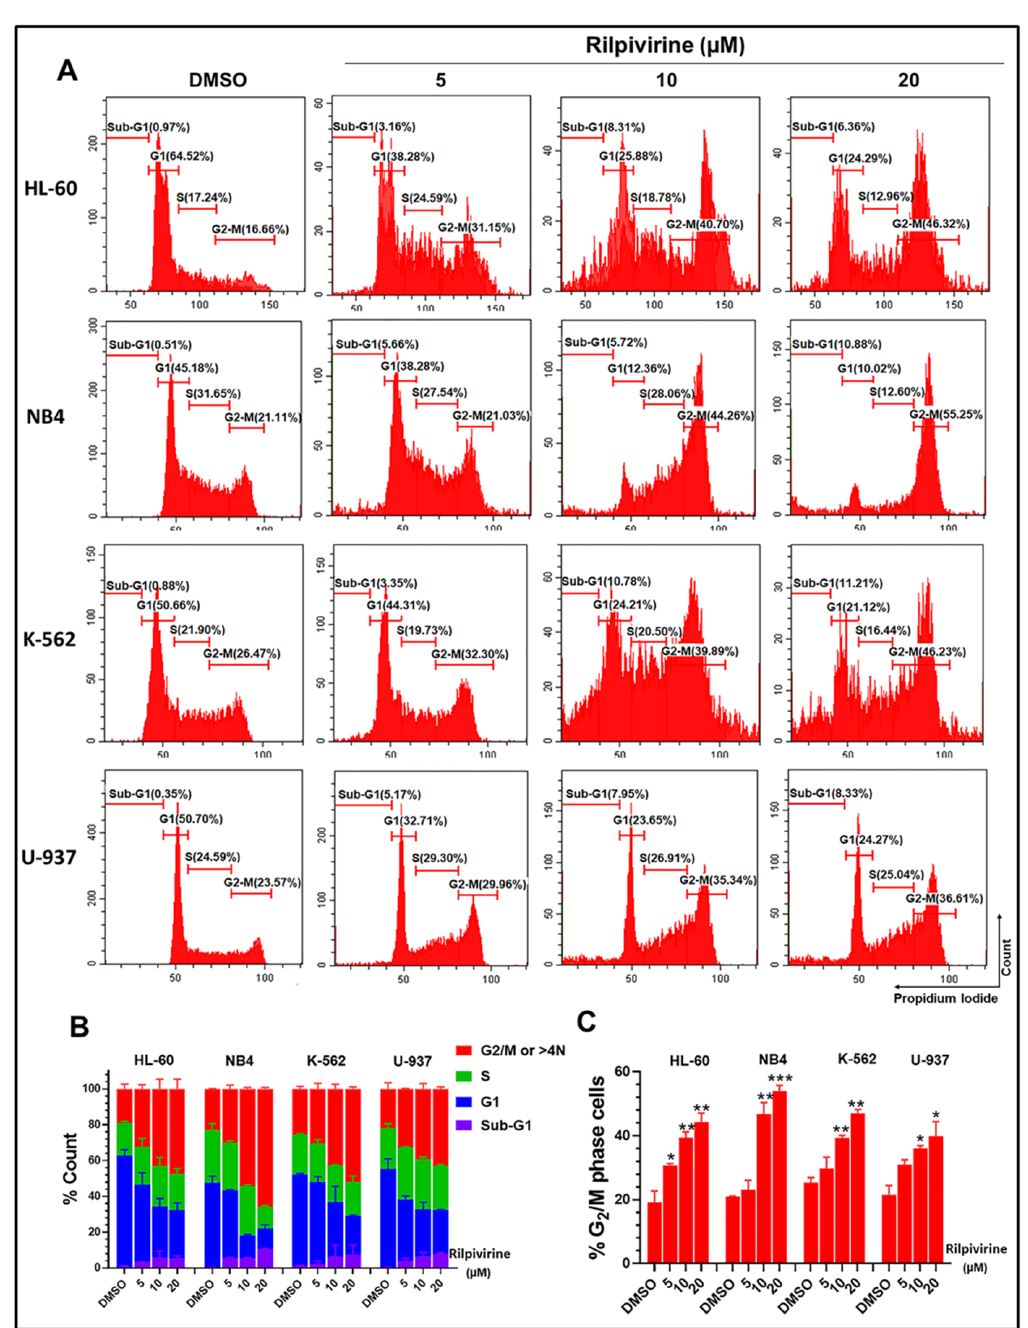
Figure 3. Cell-cycle analysis of leukaemic cells following treatment with rilpivirine. HL-60, NB4, K-562, and U-937 cells were incubated with 5, 10, or 20 µM rilpivirine for 24 h. ( A ) Representative histograms show the distribution of cells in different cell-cycle phases. ( B ) The percentages of cells distributed in different phases of the cell cycles of the tested cell lines. ( C ) The percentages of cells accumulated in the G 2 /M phases of the respective cell lines. Data (mean ± SD) were presented from at least two independent experiments (* p < 0.05, ** p < 0.01, and *** p <